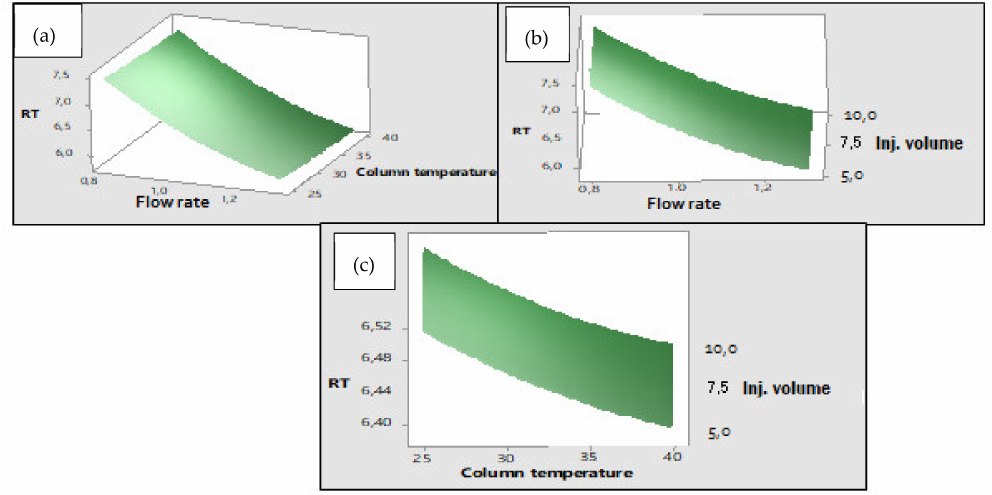
Figure 5. ( a ) The surface plot of the effects of flow rate and column temperature on t R while keeping injection volume constant; ( b ) effects of injection volume and flow rate on t R while keeping column temperature constant; and ( c ) effects of column temperature and injection volume on t R while keeping flow rate